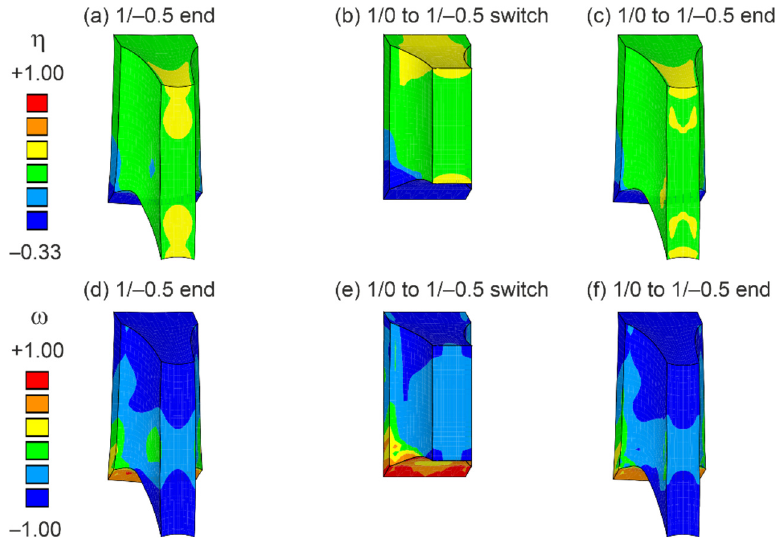
Figure 5. Distribution of stress triaxiality η and Lode parameter ω over cross section of notch for load cases 1/ − 0.5 ( a , d ) and 1/0 to 1/ − 0.5 ( b , c , e , f ).